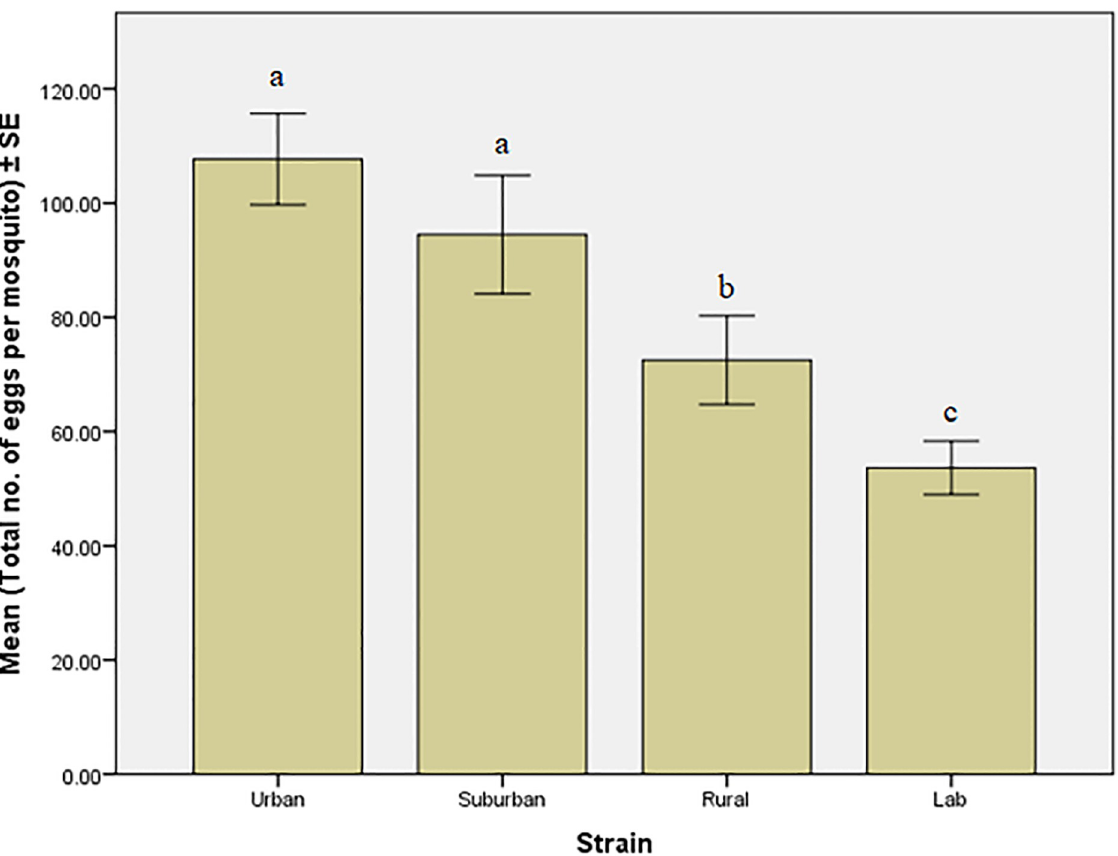
Fig 2. Total number of eggs produced by individual Aedes albopictus females in four different strains. �� the same letter indicated no significant difference between strains (P > 0.05). �� different letters indicated significant difference between strains (P < 0.05).